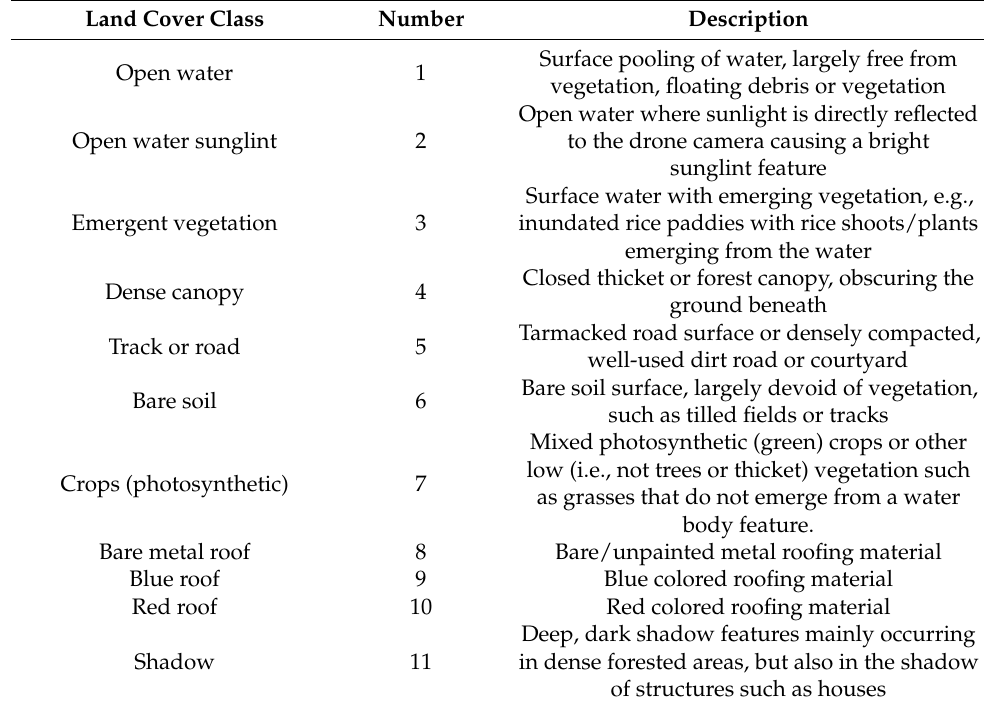
Table 1. Nomenclature used in the supervised classification of drone imagery.